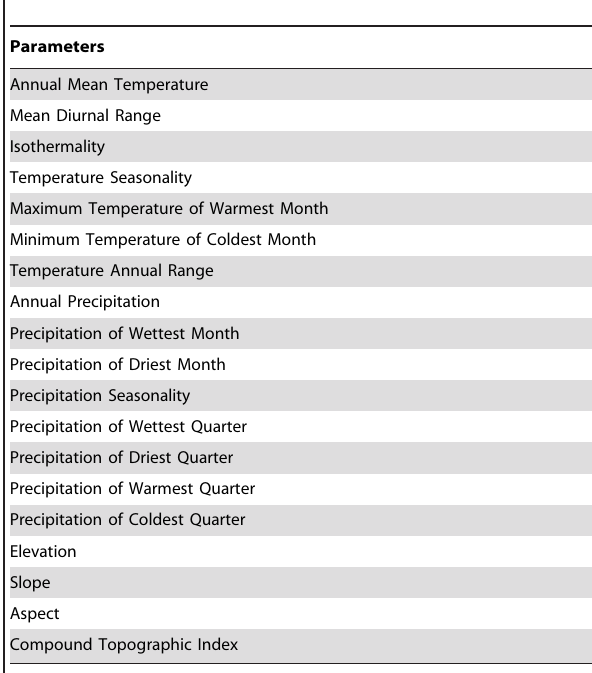
Table 1. Environmental parameters for species distribution